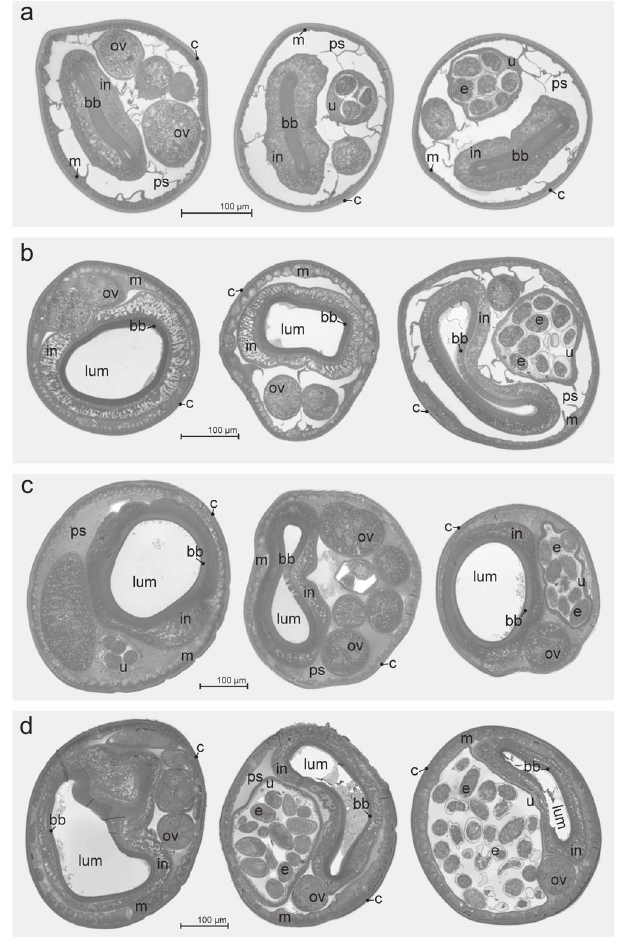
Figure 1. Differences between Haemonchus contortus sections obtained either from goats fed a polyphenol-free diet (a), goats fed with tzalam fodder (b), drenched with quebracho (c) or fed sainfoin fodder (d). Cross-section of worms show cuticle (c), muscle (m), intestine (in), lumen of intestine (lum), brush border (bb), ovary (ov), uterus (u), egg sections (e) and pseudocoele (ps). Stained with Methylene blue (Azur